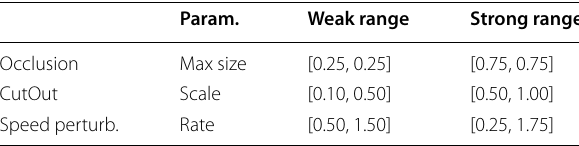
Table 1 Augmentation hyperparameters